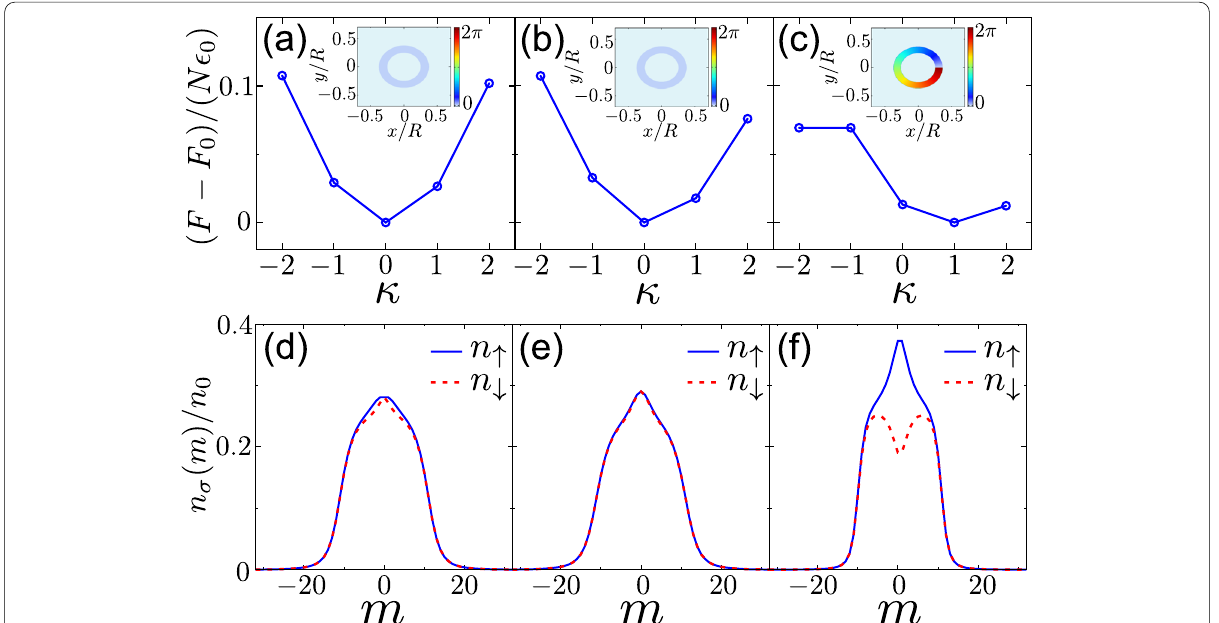
1.6 . The insets show the phase of the order = − 0.18 . Adapted from Ref. =